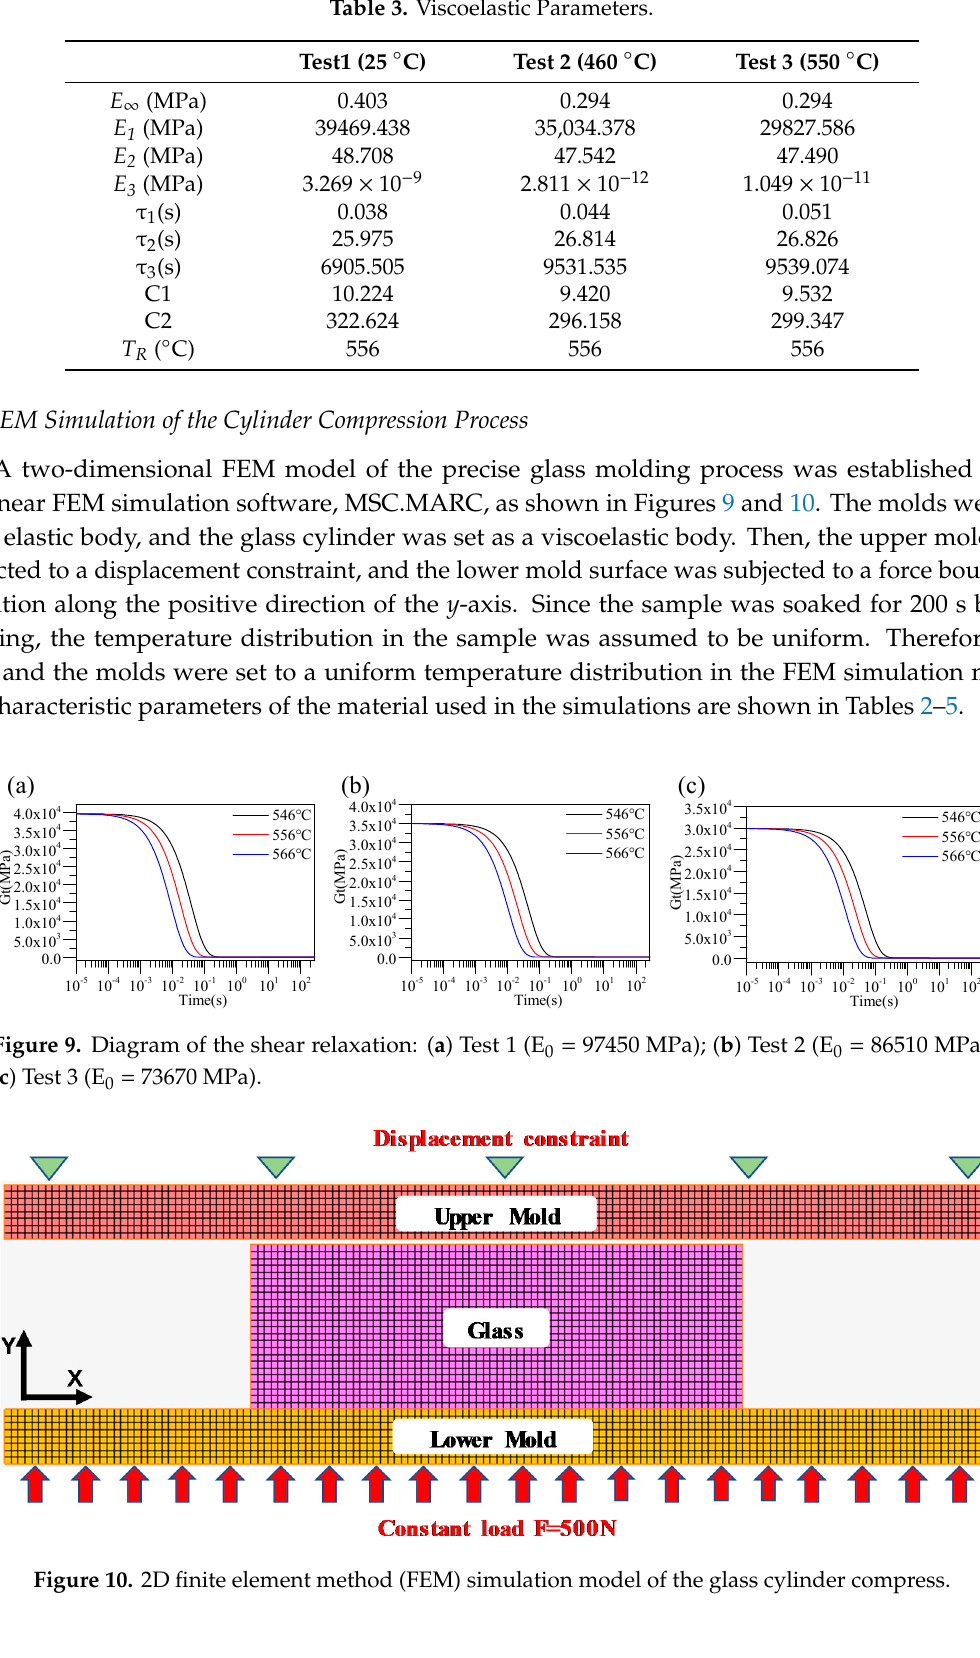
Table 3. Viscoelastic Parameters.